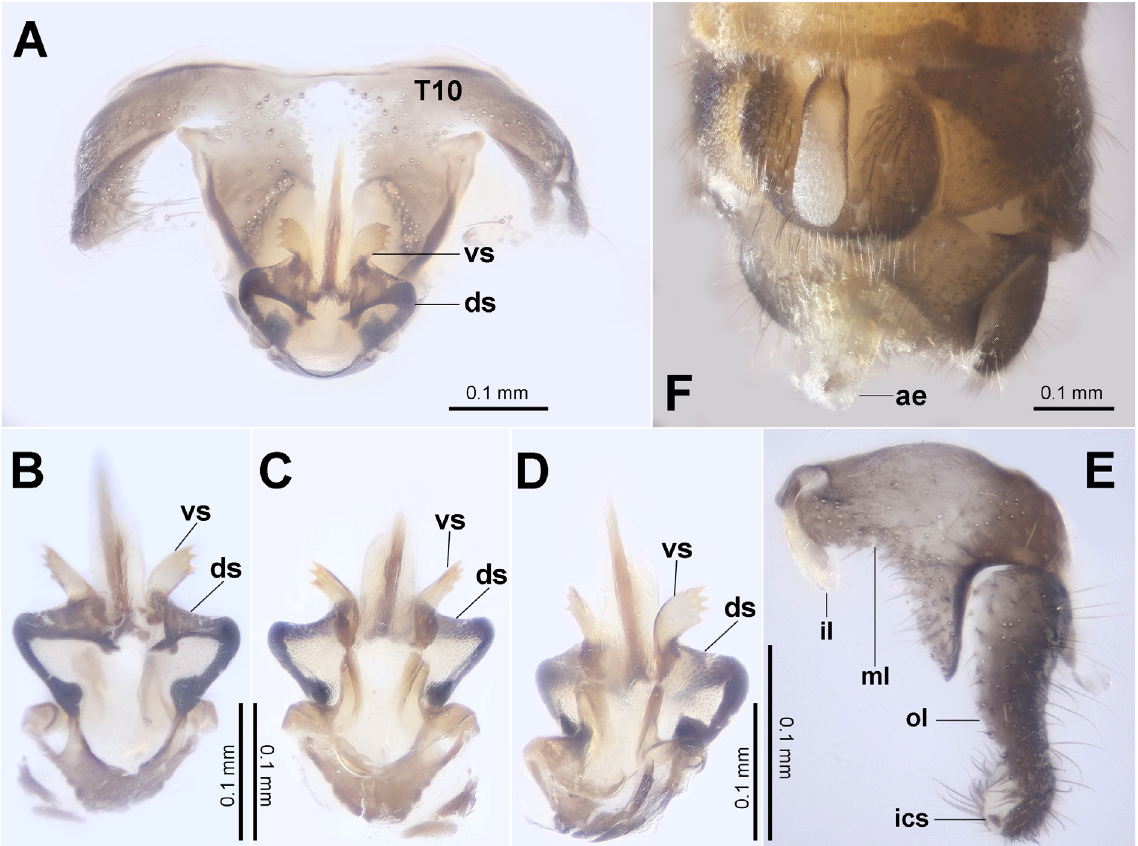
Fig. 4. Nemoura lixiana sp. nov. A . Male tergum 10 and epiproct, dorsal view. B . Male epiproct, dorsal view. C . Male epiproct, ventral view. D . Male epiproct, ventrolateral view. E . Male paraproct, dorsal view. F . Male paratype with aedeagus extruded, ventral